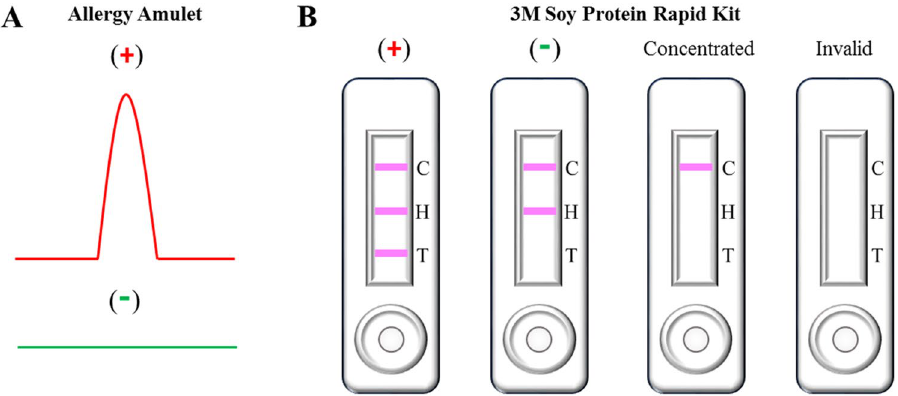
Figure 1. Illustrative responses from: Allergy Amulet kit ( A ) and 3 M Soy Protein Rapid kit ( B ). The Allergy Amulet sensor records a positive reading when a distinct oxidation peak for soy allergen tracer is present at approximately 0.60 V vs Ag/AgCl reference electrode. For the LFD test kits a positive result is visualized by the presence of three lines: a control line (C), a hook line (H) and a test line (T). Negative LFDs results were indicated by the presence of a control and a hook line only. Concentrated LFDs results were indicated by the presence of control line while the invalid results were indicated by the absences of all of three